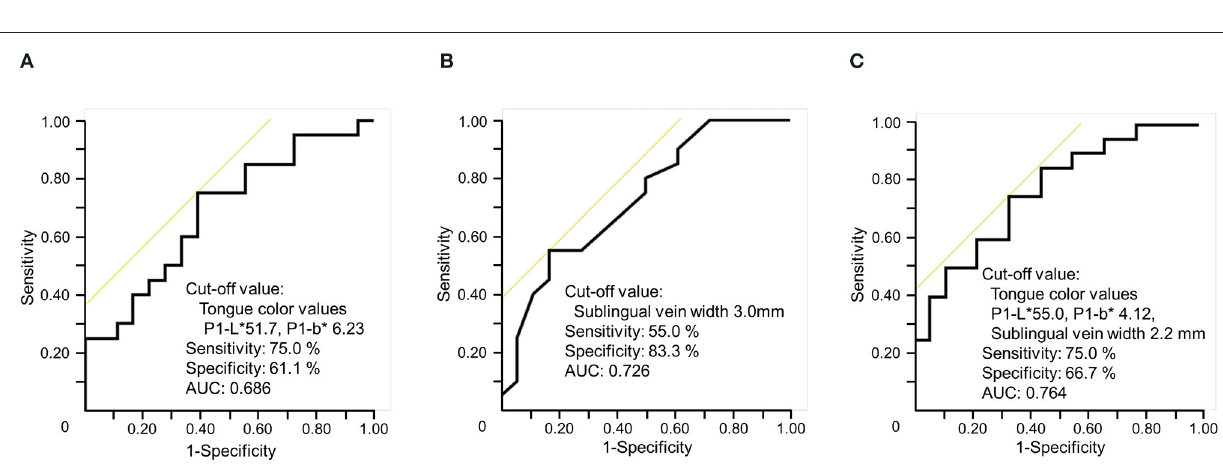
FIGURE 3 | Indicator to differentiate blood stasis by ROC analysis. (A) Only the tongue color values (P1-L*, P1-b*). (B) Only the sublingual vein width. (C) Both the tongue color values (P1-L*, P1-b*) and the sublingual width P1 (tongue edge). L* for lightness (brightness to darkness), b* chromaticity (yellowness [ + b] to blueness